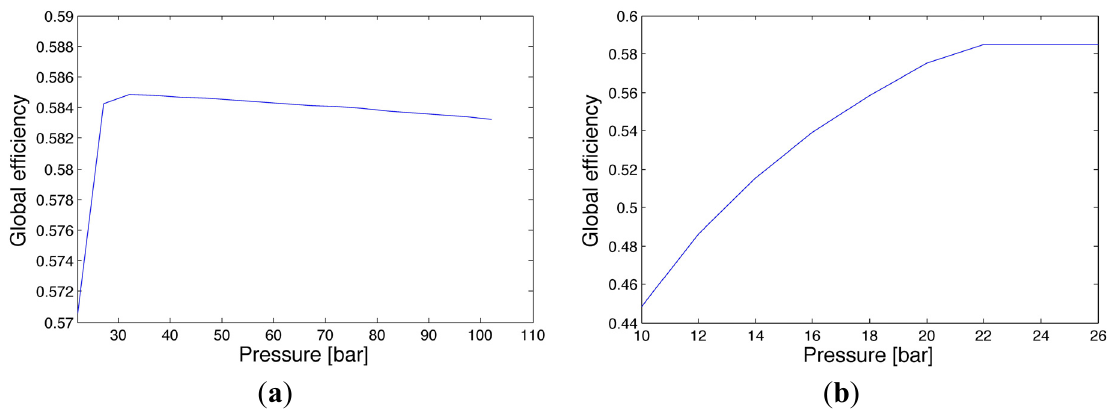
Figure 7. Effect of Boilers pressure on global efficiency: ( a ) Boiler C; ( b ) Boilers A and